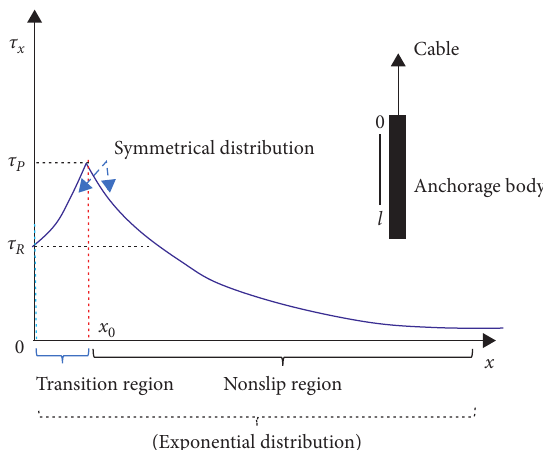
Figure 7: Double exponential shear stress